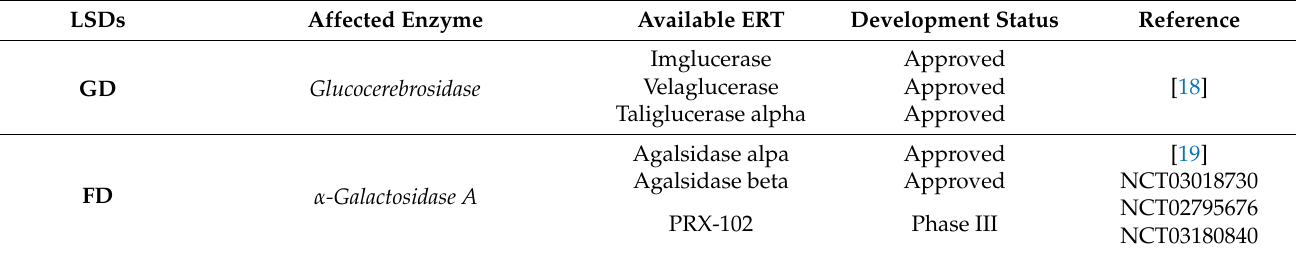
Table 1. Available ERT based medicaments for LSDs. In the reference column there are indicated either reference articles